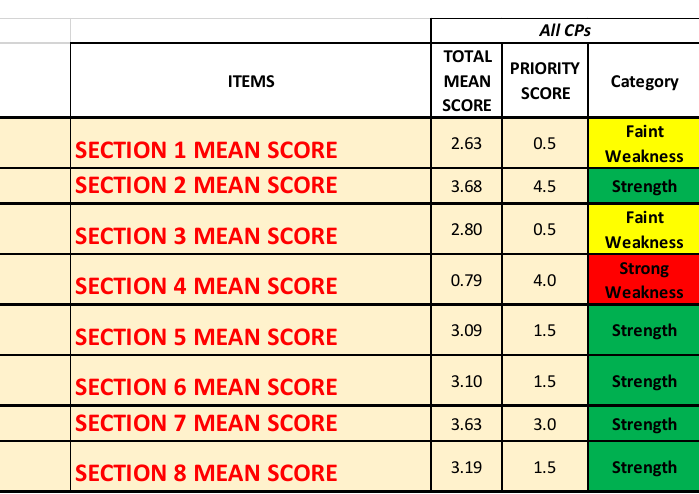
Figure 12. Summary of the results regarding all the Questionnaire Sections of all the CPs together.